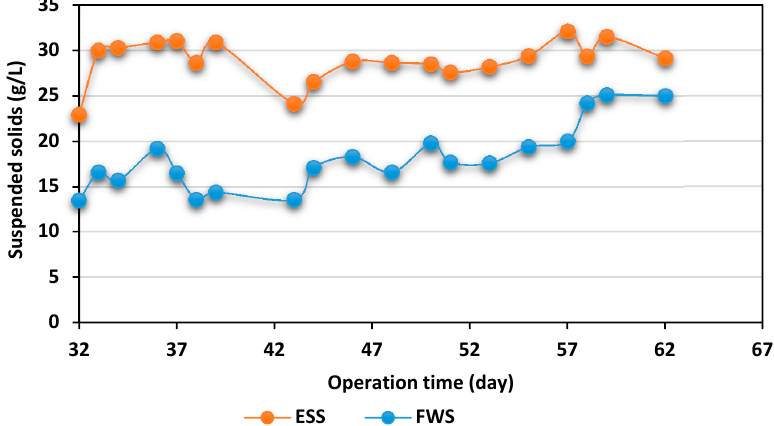
Figure 12. Suspended solid profiles of excess sewage sludge and food waste slurry iMBR.